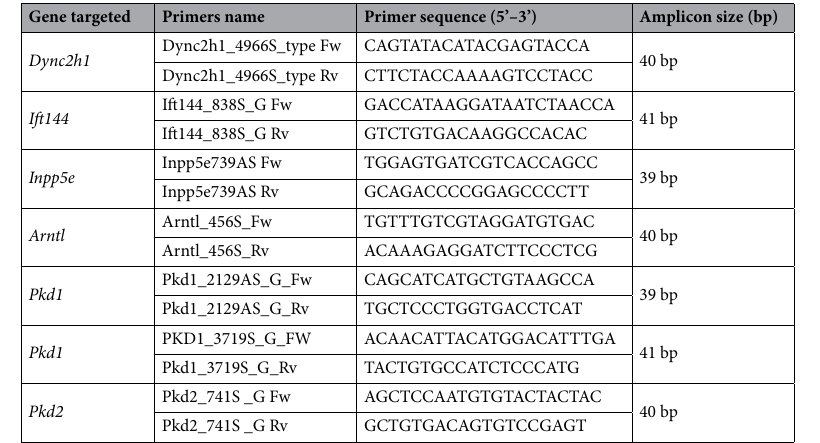
Table 1. DST-PCR primers for screening.